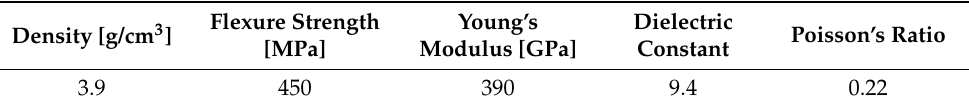
Table 1. Properties of the 99% alumina ceramic.